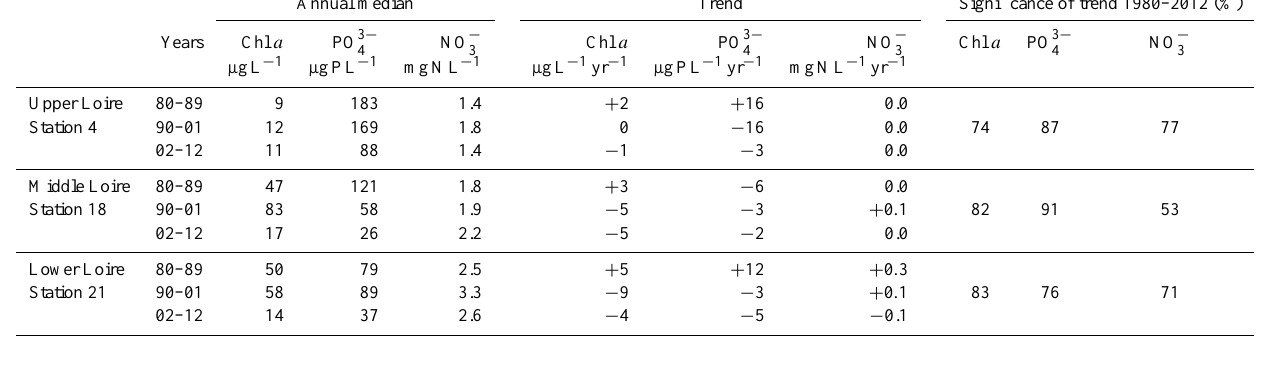
Table 3. Long-term trends at three stations representative of the Upper, Middle and Lower Loire.